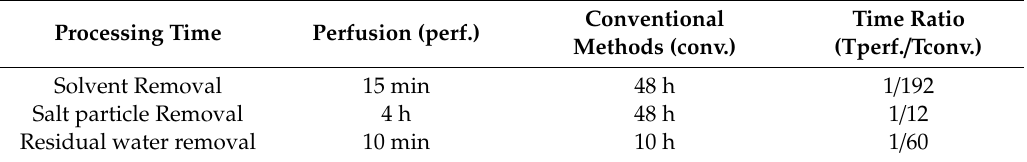
Table 1. Processing time comparison between perfusion and conventional methods. Processing Time